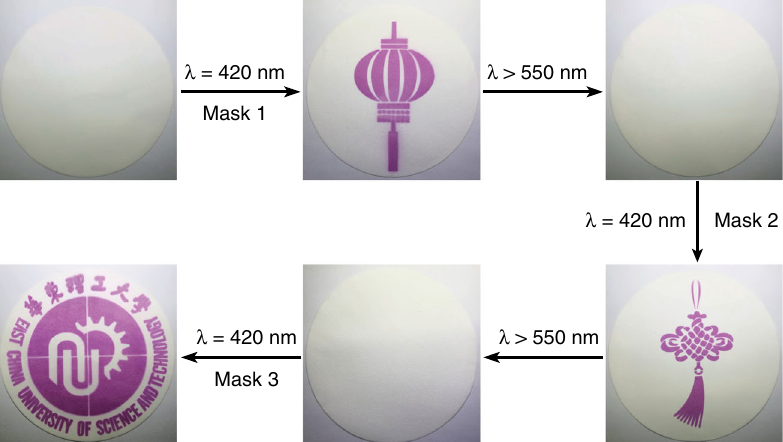
Fig. 5 All-visible-light patterning application of DAE-DT on a fi lter paper. A series of images (Chinese lantern, Chinese knot and the badge of East China University of Science and Technology) were sequentially written onto and erased from the same fi lter paper using different masks with 420 nm irradiation for 5 min and >550 nm irradiation for 15 min,